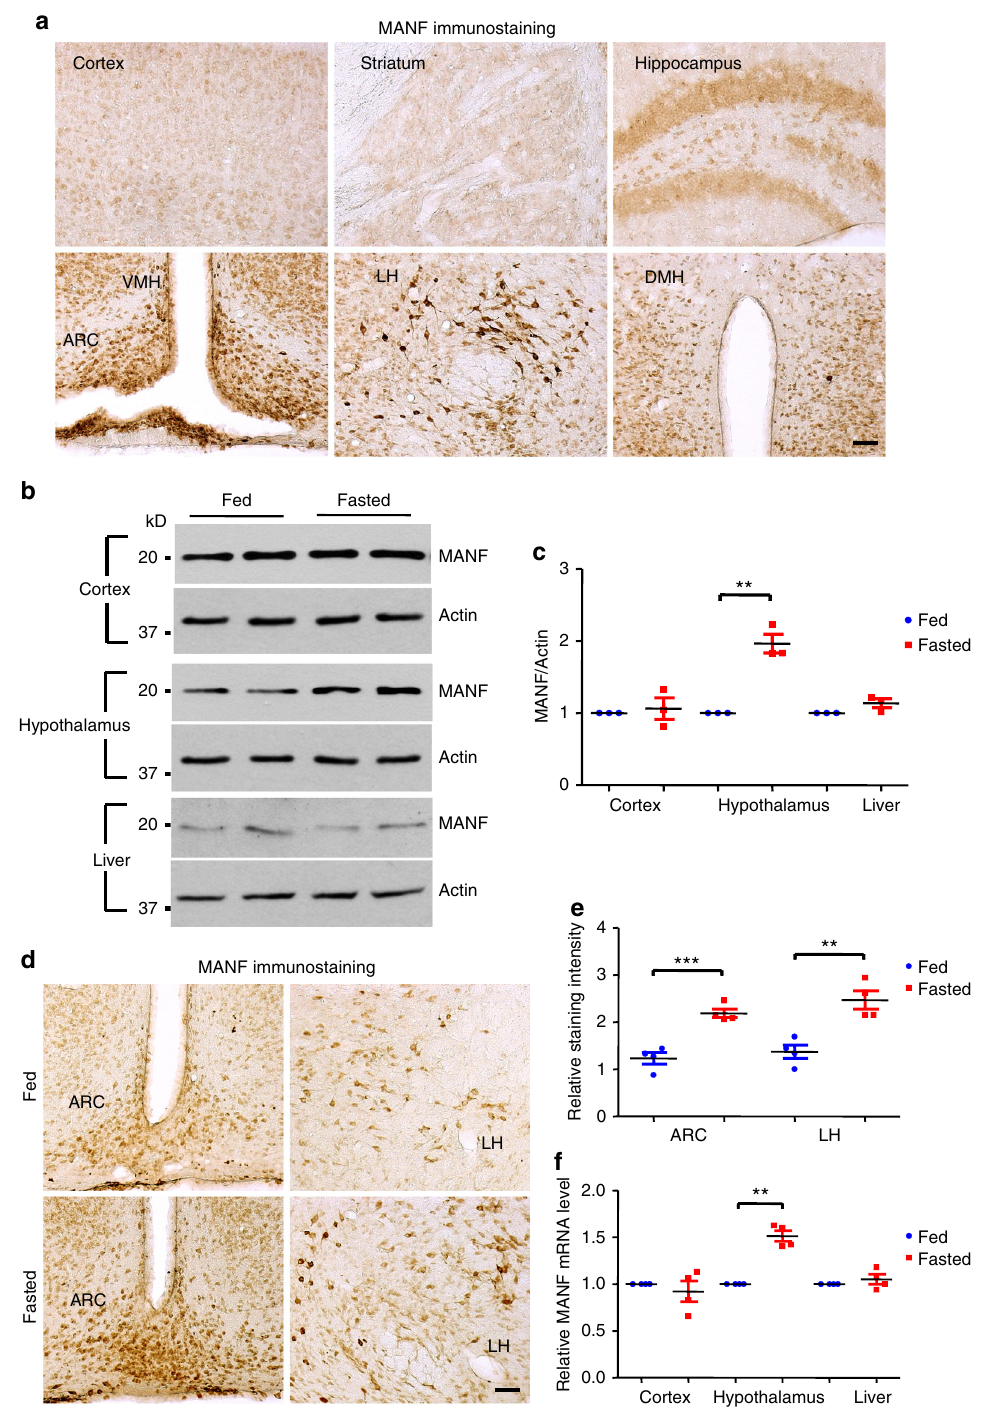
Fig. 1 MANF is enriched in the hypothalamus and upregulated by energy deprivation. a Immunohistochemistry study revealed the expression of MANF in different regions of the mouse hypothalamus, including arcuate nucleus (ARC), ventromedial hypothalamus (VMH), dorsomedial hypothalamus (DMH) and lateral hypothalamus (LH) ( Scale bar : 50 μ m). b Representative western blotting images (from three independent experiments) showed that 48 h fasting increased MANF expression speci fi cally in the mouse hypothalamus, but not in the cortex or liver. c Quanti fi cation of western blotting results in Fig. 1b (** P < 0.01, n = 3, 2-tailed student t test, t = 7.316, P = 0.0091). d Immunohistochemistry showed that 48 h fasting increased MANF staining in the hypothalamus of wild type mice ( Scale bar : 50 μ m). e Quanti fi cation of MANF staining intensity in Fig. 1d (** P < 0.01, *** P < 0.001, n = 4; 2-tailed student t test, ARC, t = 6.213, P = 0.0008; LH, t = 4.569, P = 0.0038). f qRT-PCR result indicated MANF mRNA level was signi fi cantly increased in the hypothalamus after 48 h fasting (** P < 0.01, n = 4, 2-tailed student t test, Cortex, t = 0.725, P = 0.5209; Hypothalamus, t = 8.891, P = 0.003; Liver, t = 0.9839, P = 0.3977). Data are represented as mean ± SEM. Whenever you refer to a student t-test in a fi gure legend, please state whether test was 1-tailed or